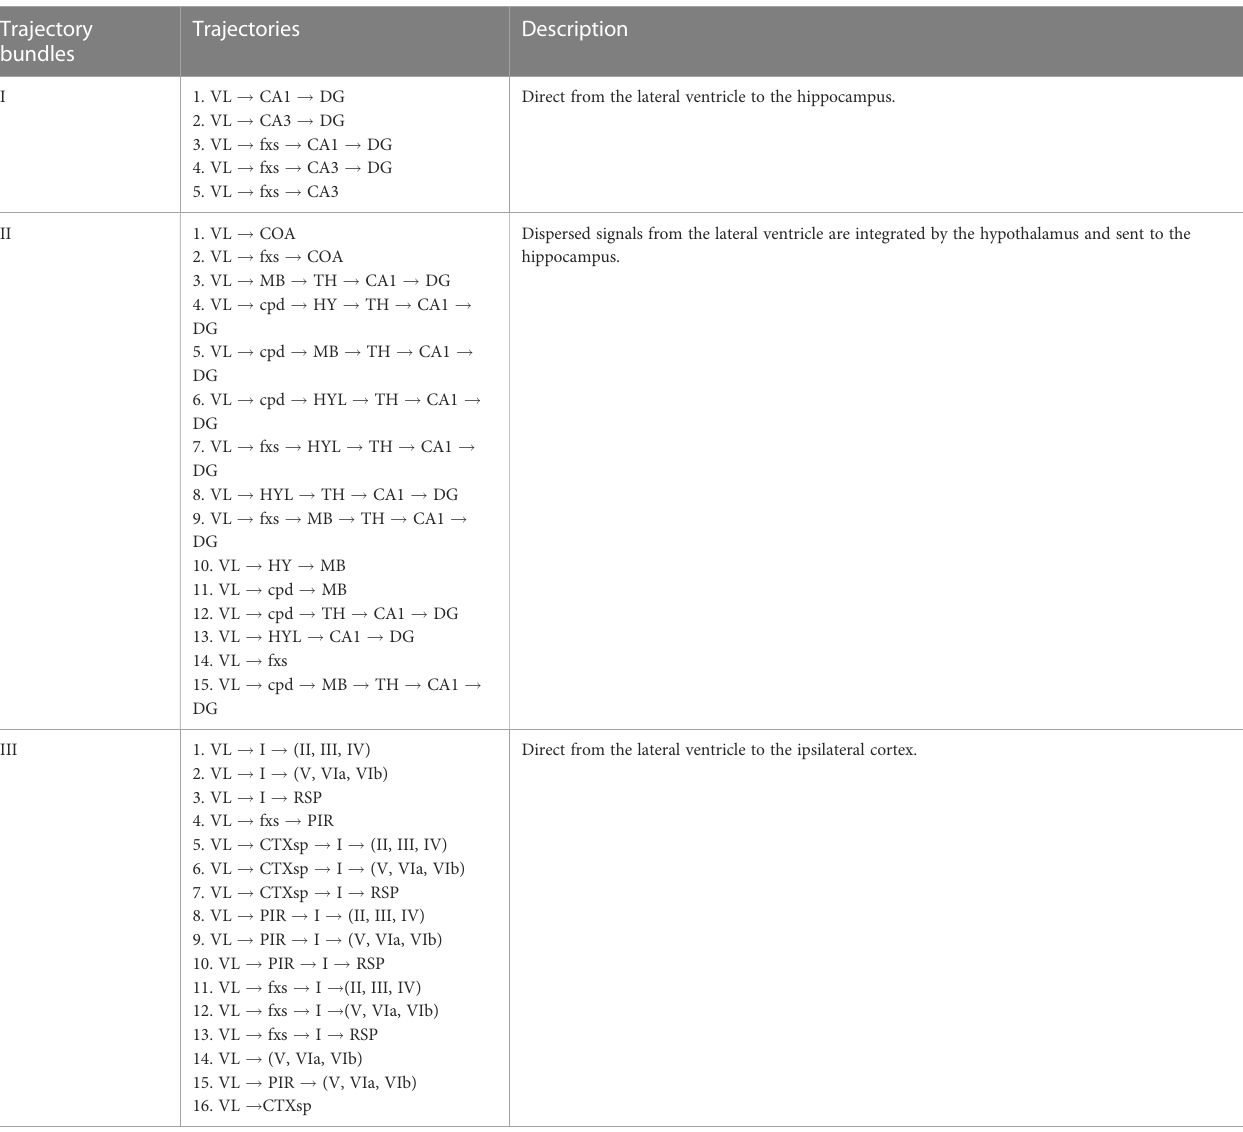
TABLE 1 Three major trajectory bundles from the lateral ventricle to the hippocampus and primary cortex after hematoma